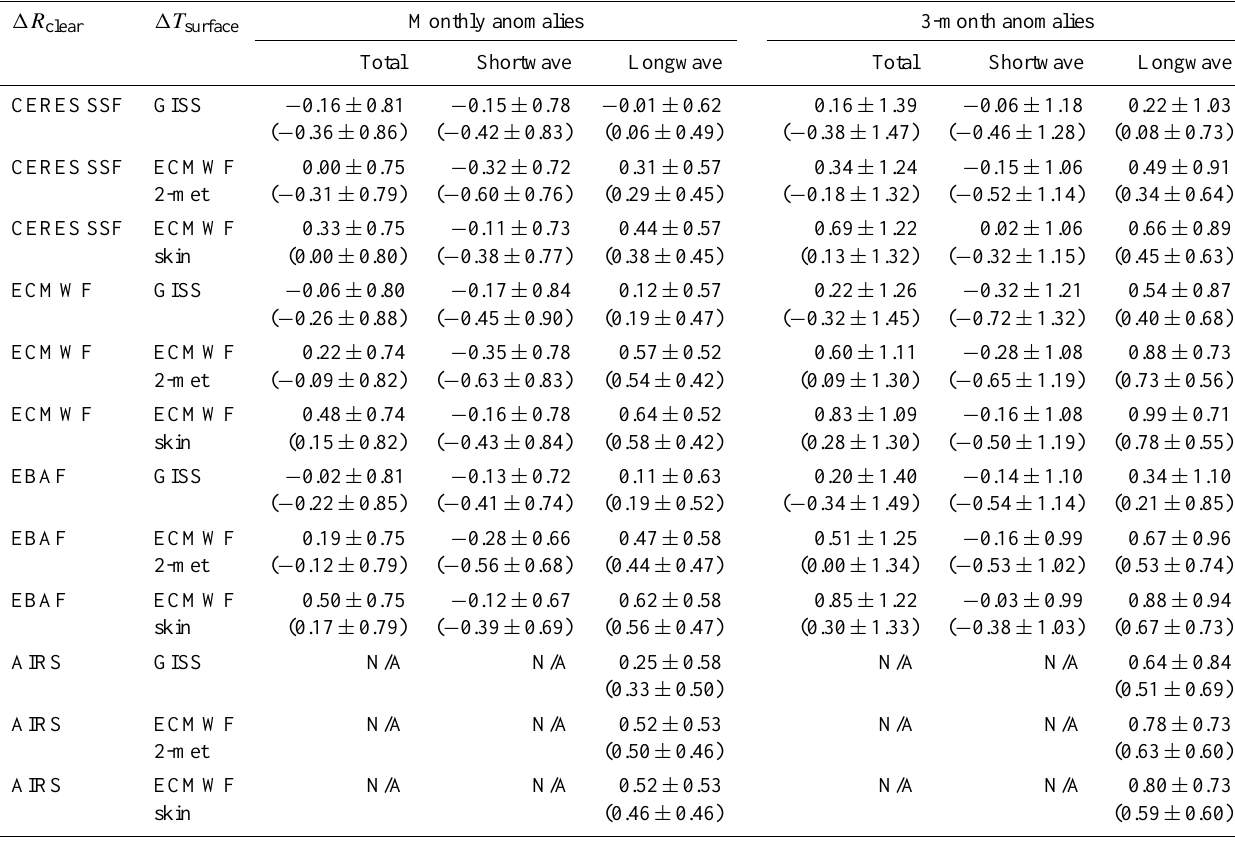
Table 2. The results of OLS regressions of 1R cloud against 1T surface , with 95% confidence interval over the September 2002 to June 2011 Aqua period. Values in parentheses use the unadjusted values of 1 CRF in the regressions. All estimates are in Wm − 2 K − 1 .